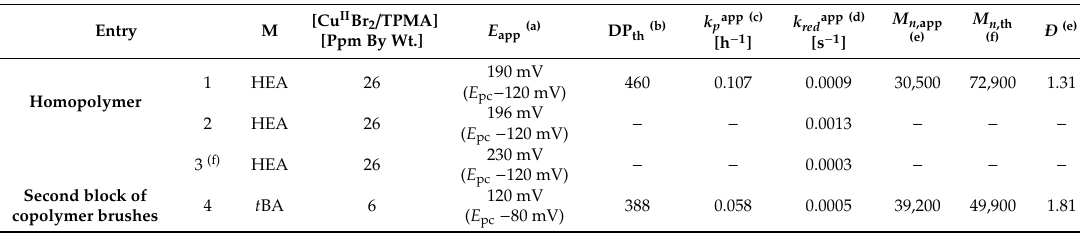
Table 1. Summary of homopolymer and block copolymer chains generated in solution during sacrificial initiator-assisted ultralow ppm SI- se